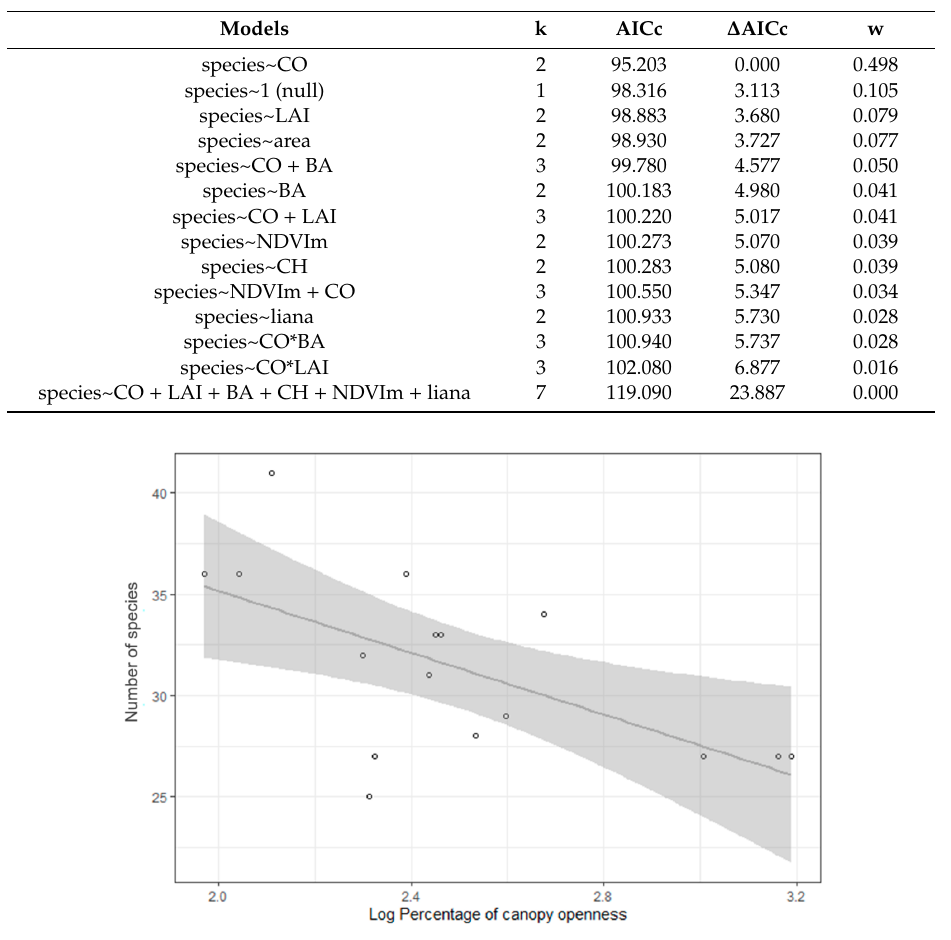
Figure 5. Percentage of canopy openness (log) explaining variation in bird species richness. Confidence intervals at 95% shaded area, R 2 = 0.38.